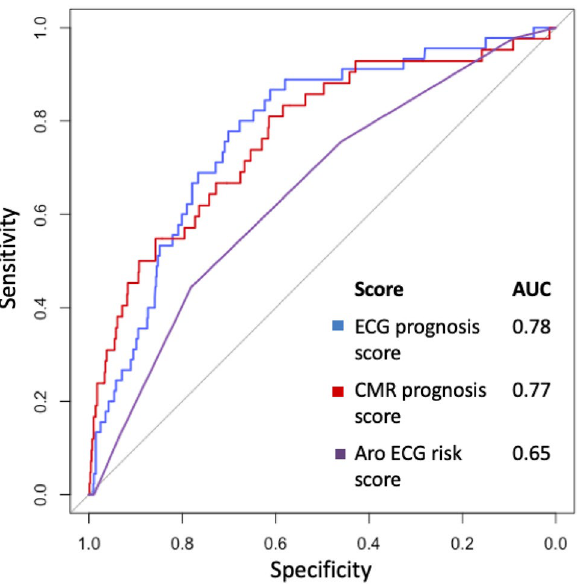
Figure 1. Receiver operating characteristics curve for the ECG and CMR prognosis scores, respectively, and the Aro ECG risk score. The area under the curve (AUC) for the ECG prognosis score was greater than for the Aro ECG risk score, p < 0.001.